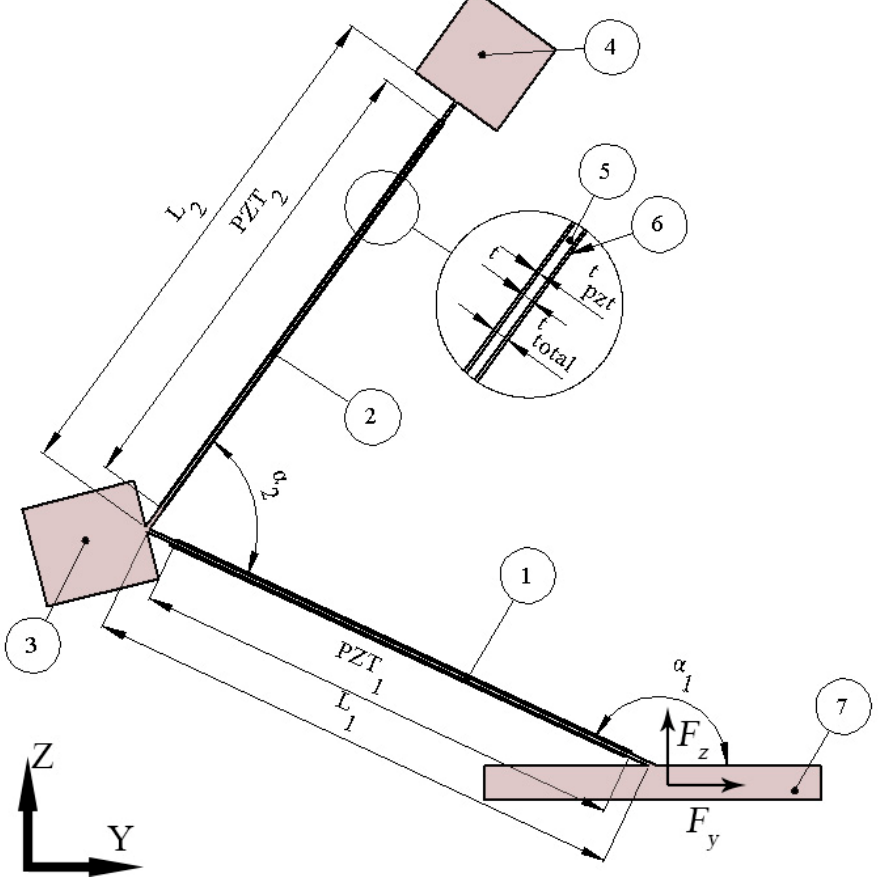
Figure 1. Schematics of bidirectional energy harvester; 1,2—the first and second cantilever, respectively; 3,4—seismic masses, M 1 and M 2 , respectively; 5—body of the harvester; 6—piezoelectric material made of PIC255 piezo ceramics; 7—clamping base.